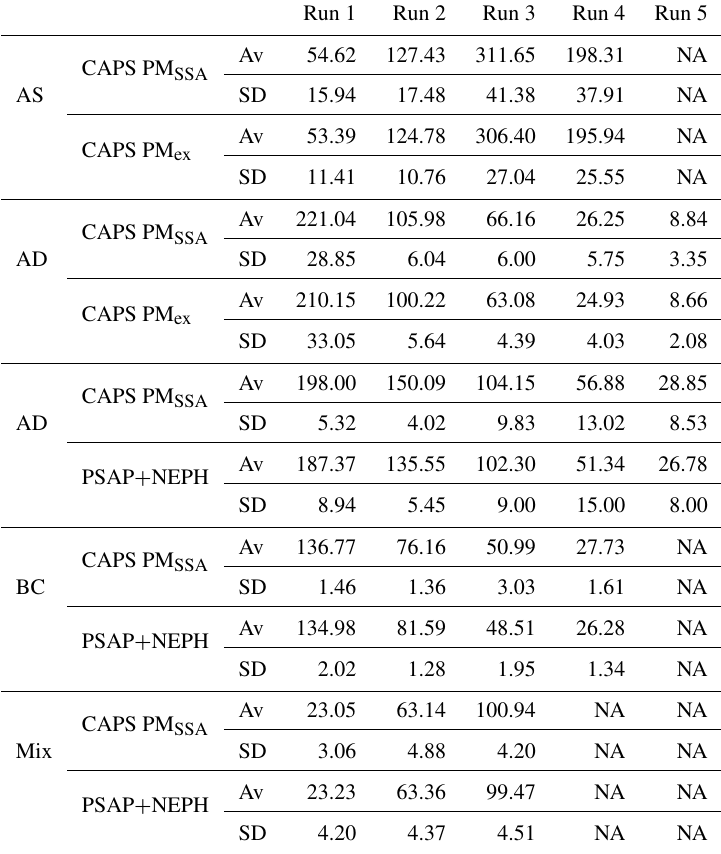
Table A1. Extinction coefficient mean and 1 σ of the mean measured by the CAPS PM SSA extinction channel and proven technologies.